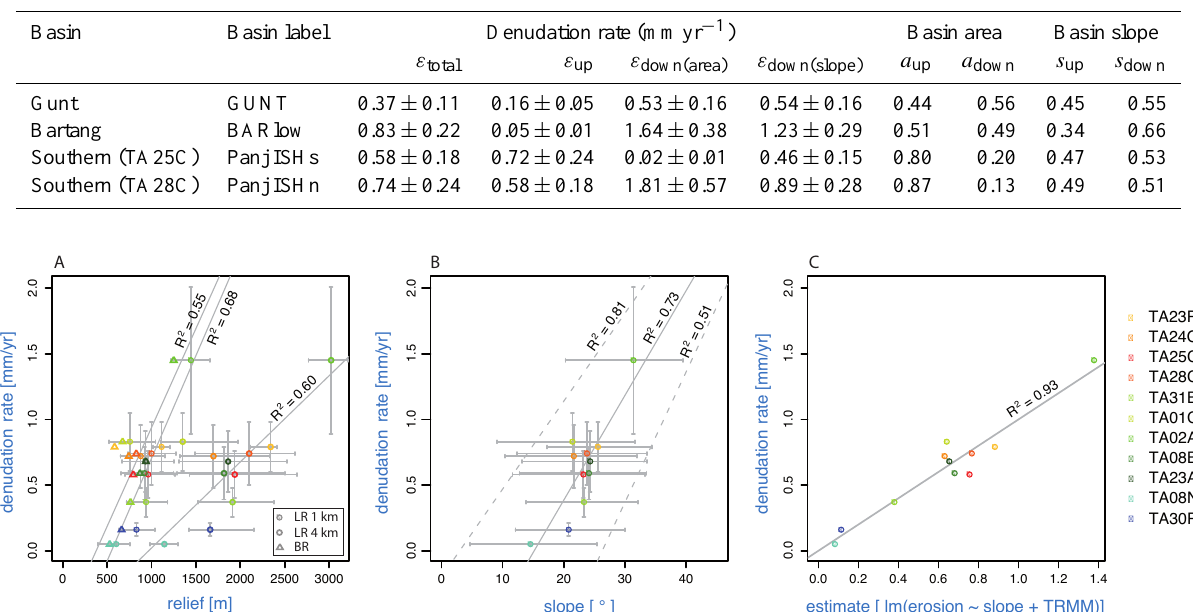
Table 3. Approximated denudation rates of sub-basins using weighting factors that account for basin area ( a ) and basin slope ( s ). The weighting factors a and s are applied to determine variations in denudation within large basins when the rates are known (determined based on measured 10 Be concentrations and corresponding production rates) for the entire basin and one of its sub-basins ( ε : denudation rate; total: sample data for entire basin; up: sample data for upper sub-basin; down: inferred rate for lower sub-basin using the area or slope-based weighting factors; a : area factor describing the proportion of the respective sub-basin normalized to 1; s : slope factor describing the slope variations in sub-basins normalized to 1).